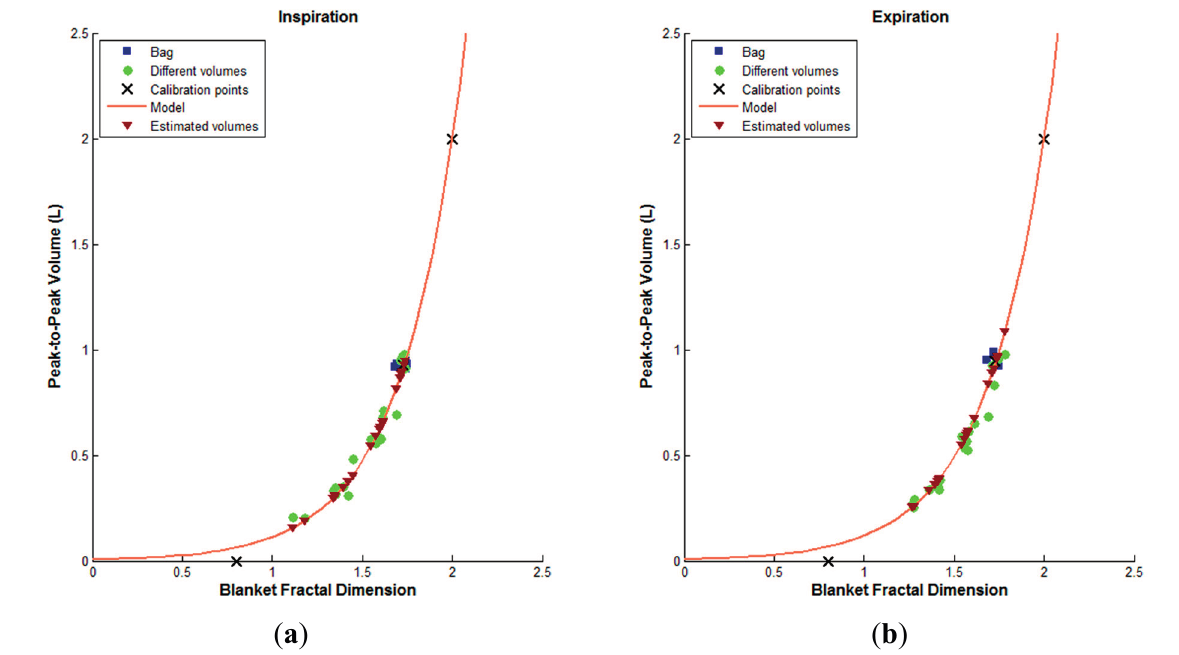
Figure 5. An example of the volume estimation from smartphone acquired tracheal sounds using BFD features and exponential model of one subject. The true volumes while breathing through a tube (green circles) are limited to a range from 0.2 to 1 L. ( a ) The inspiration phase; ( b ) The expiration phase.